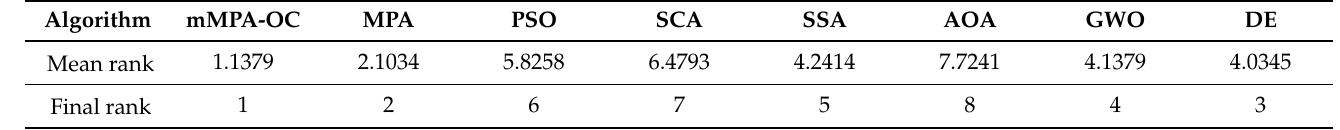
Table 14. Average ranking of the Friedman test on CEC-2017 (30